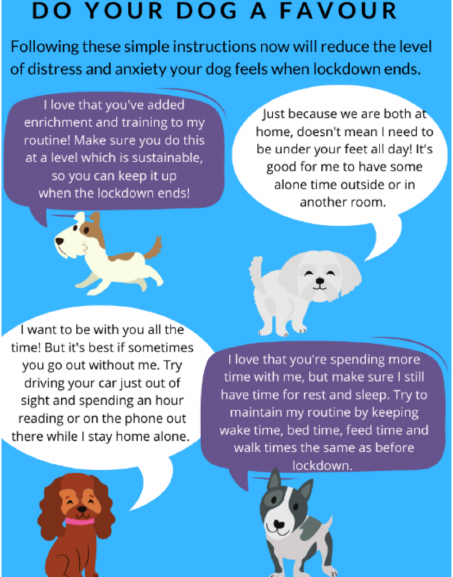
Figure 3. The most engaged with Facebook post by Companion Animals New Zealand providing information to reduce separation anxiety in dogs